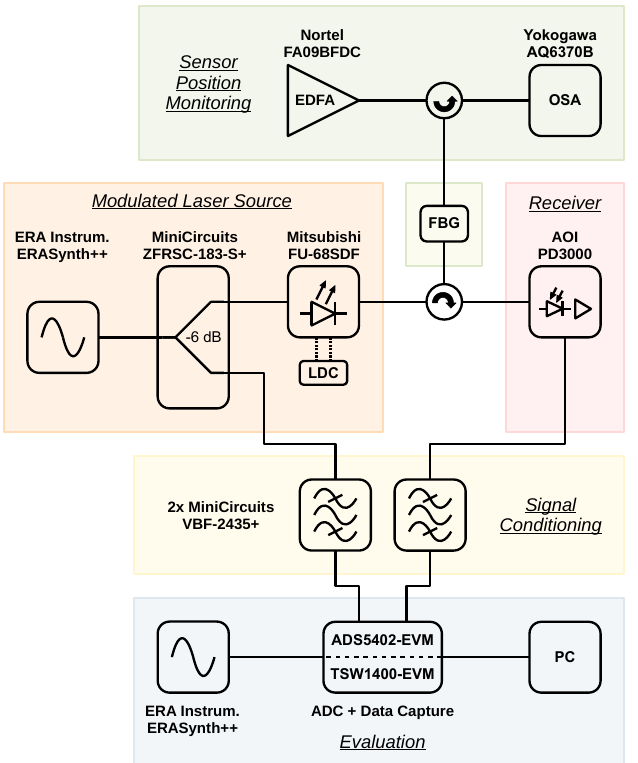
Figure 1. Block diagram of the experimental